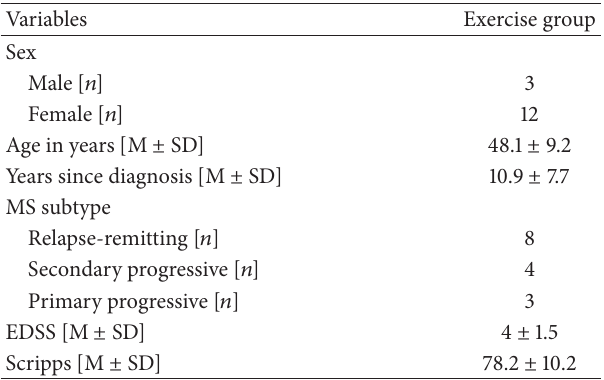
Table 4: Characteristics of the experimental